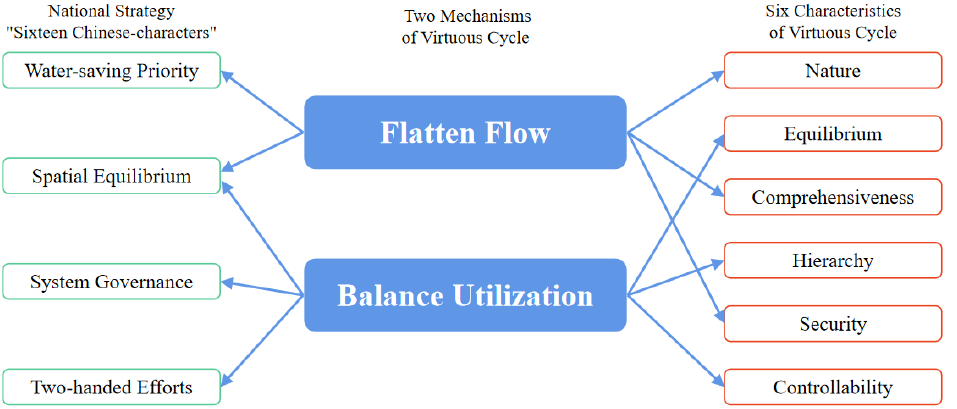
Figure 5. Relationship between the National Strategy and Virtuous